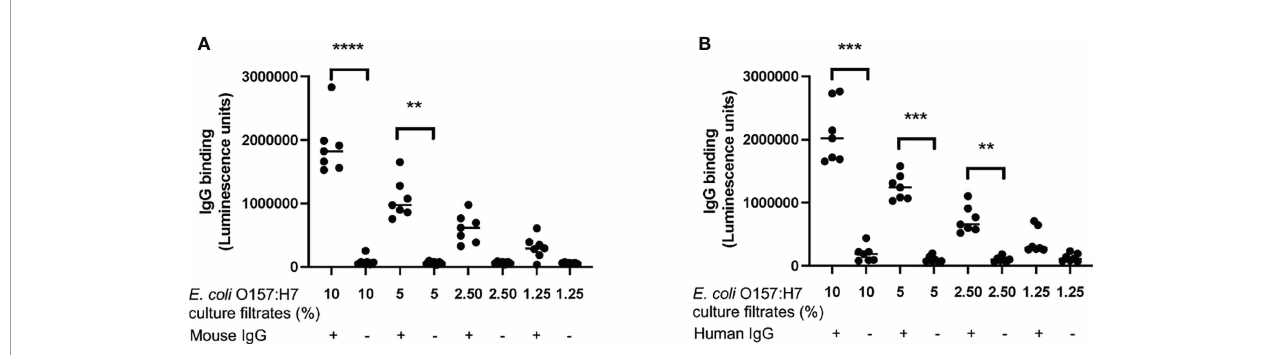
FIGURE 4 | IgG binding to E. coli O157:H7. The binding of IgG to E. coli O157:H7 culture fi ltrate was analyzed by ELISA. (A) Mouse IgG exhibited dose-dependent binding to E. coli O157:H7 culture fi ltrate. (B) Human IgG showed dose-dependent binding to E. coli O157:H7 culture fi ltrate. The bar represents the median. **P < 0.01, ***P < 0.001, ****P < 0.0001.